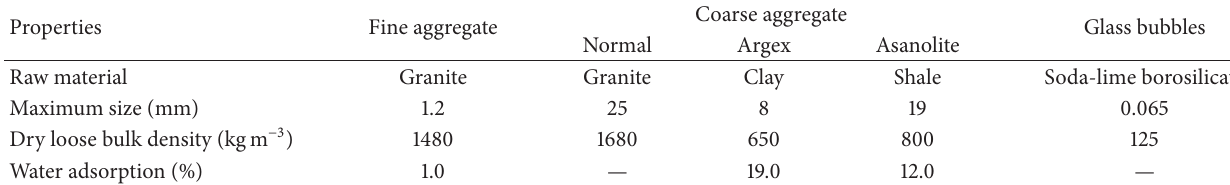
Table 1: Physical properties of glass bead, fine, normal, and lightweight aggregates.